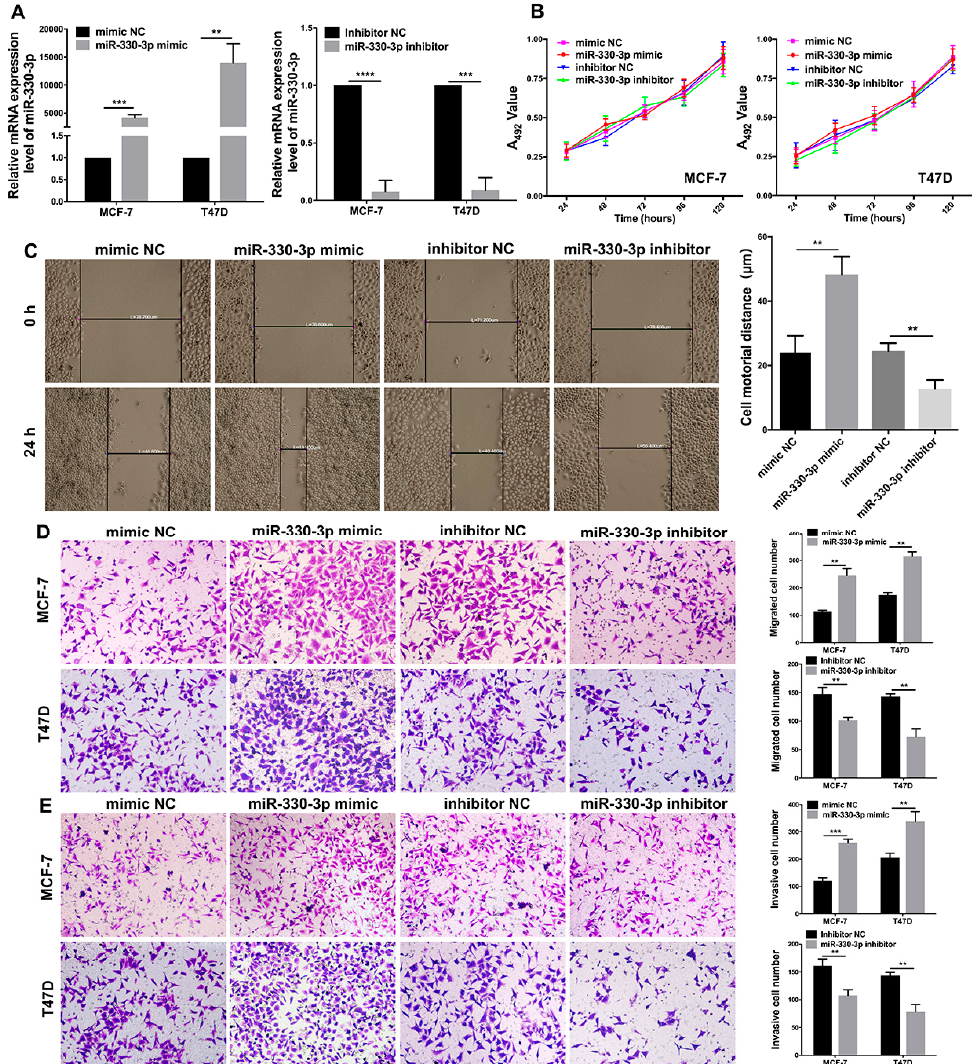
Figure 2. The influences of miR-330-3p on the proliferation, motility, migration, and invasion of BC cells. ( A ) In MCF-7 and T47D, the over-expression and knockdown of miR-330-3p were determined via qRT-PCR. ( B ) MTT assay was used to analyze the proliferations of MCF-7 and T47D cells. ( C ) The cell motilities of MCF-7 cells transfected with miR-330-3p mimic or inhibitor were measured via wound healing assay. The transwell assays were performed for cells’ ( D ) migrations and ( E ) invasions. (** p < 0.01, *** p < 0.001, **** p < 0.0001, n = 3). The influences of miR-330-3p on the migrative and invasive abilities of BC cells were addressed using transwell assays. MiR-330-3p overexpression improved the migration and invasion of MCF-7 and T47D cells (Figure 2D,E). The numbers of migrated MCF-7-miR-330-3p-mimic (245.7 ± 23.8) and T47D-miR-330-3p-mimic (315.0 ± 16.7) cells were increased by 53.9% ( p = 0.0083) and 44.8% ( p = 0.0086) compared to those of the MCF-7-mimic-NC (113.2 ± 4.4) and T47D-mimic-NC cells (173.9 ± 8.7), respectively. The numbers of invaded MCF-7-miR-330-3p-mimic (259.3 ± 14.5) and T47D-miR-330-3p-mimic (338.0 ± 35.8) cells were increased by 53.6% ( p = 0.0002) and 39.1% ( p = 0.0091) compared to those of the MCF-7-mimic-NC (120.3 ± 11.5) and T47D-mimic-NC cells (206.0 ± 16.0), respectively. Consistently, miR-330-3p downregulation inhibited the migration and invasion of MCF-7 and T47D cells (Figure 2D,E). The numbers of migrated MCF-7-miR-330-3p-inhibitor (101.7 ± 5.0) and T47D-miR-330-3p-inhibitor (72.3 ± 14.4) cells were reduced by 32.4% ( p = 0.0069) and 49.6% ( p = 0.0071) compared to the MCF-7-inhibitor-NC (147.5 ± 11.5) and